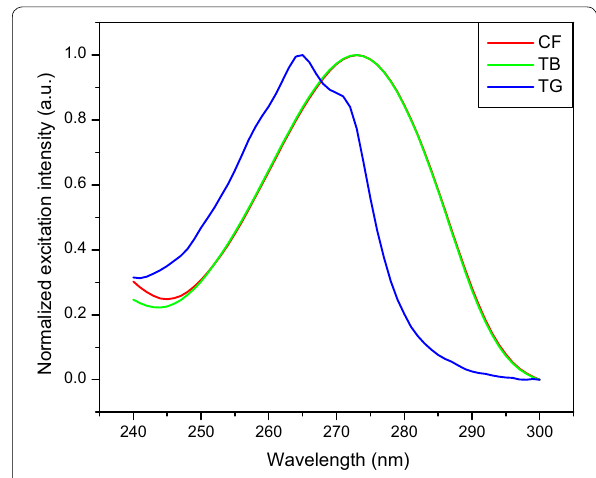
Fig. 2 UV–VIS excitation spectra of coffee alkaloid standards dis‑ solved in water. CF caffeine, TB theobromine, TG